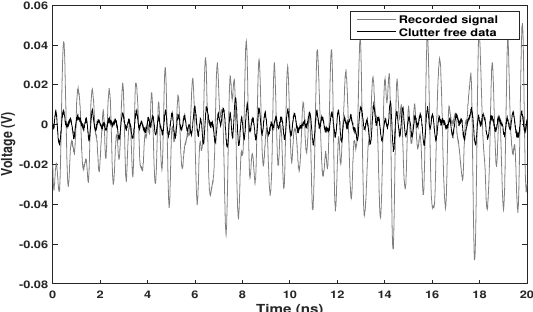
Figure 5. One waveform collected by the receiver and the signal after the clutter removal.